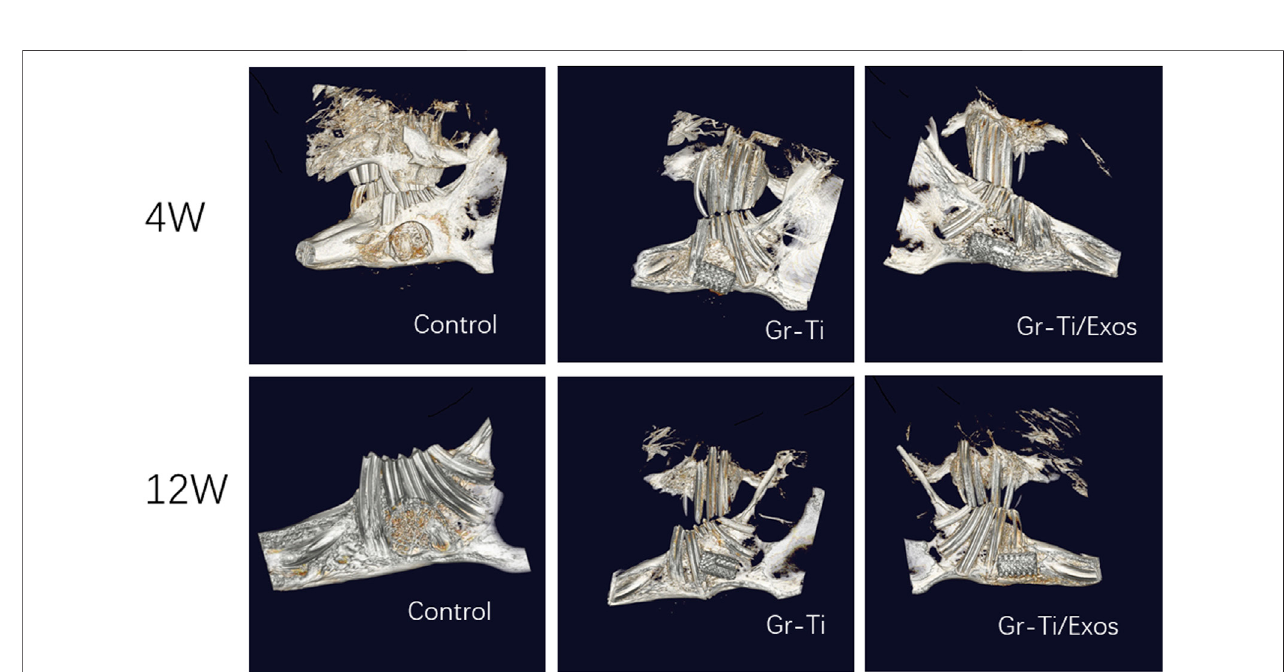
FIGURE 11 | Computerized tomography (CT) images after 4 and 12